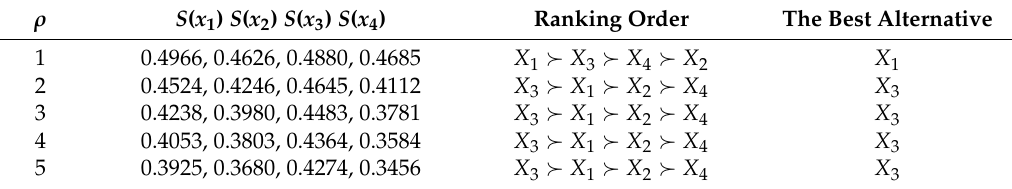
Table 2. Ranking results of the NCDWGA operator for different operational